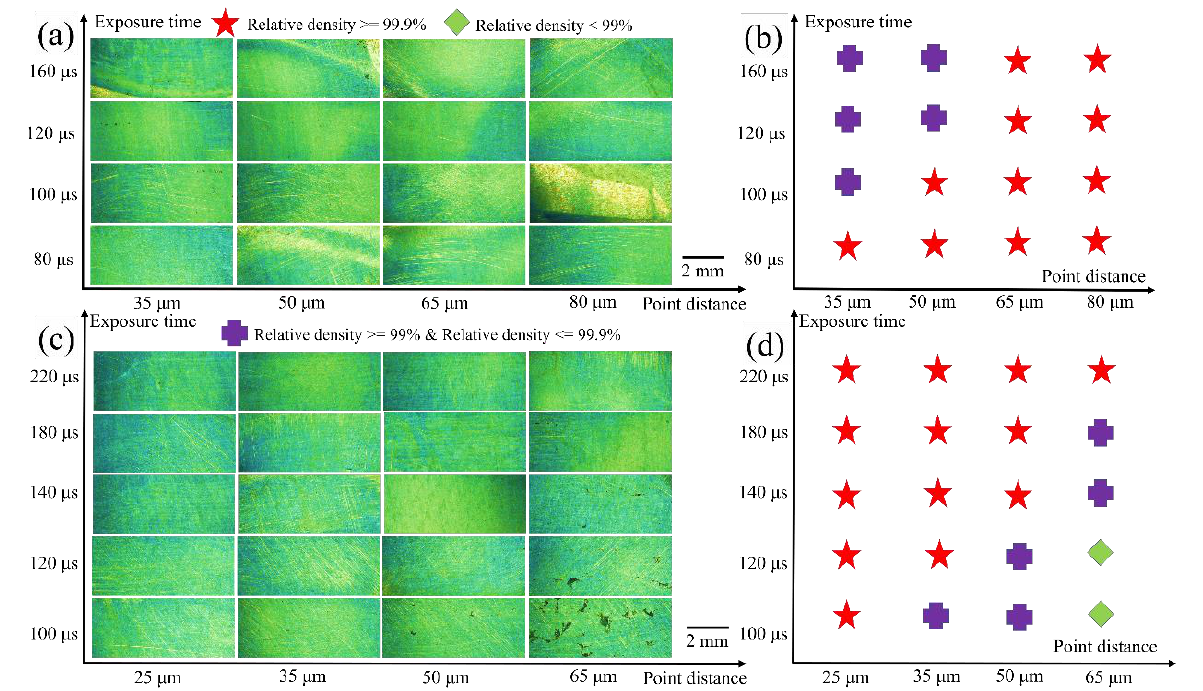
Figure 5. Specimen formed with 380 W laser power ( a ) the cross-sectional morphology of the specimen under the layer thickness of 50 μm; ( b ) statistical results of ( a ); the cross-sectional morphology of the specimen under the layer thickness of 150 μm; ( d ) statistical results of ( c ).